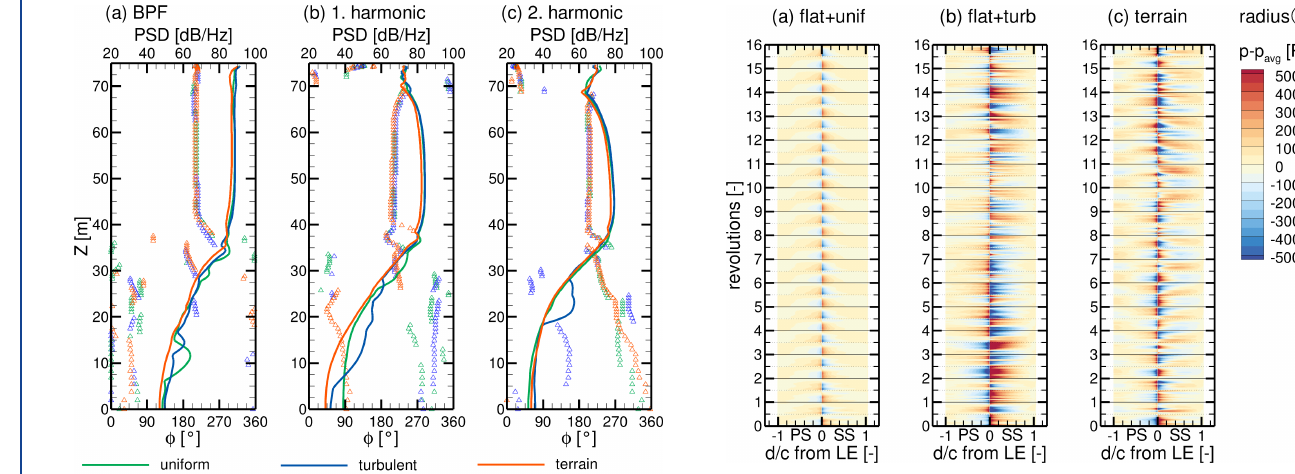
Figure 23. Time series of surface pressure fluctuations p − p avg along a blade section at the radius (4) for all cases (a) – (c)